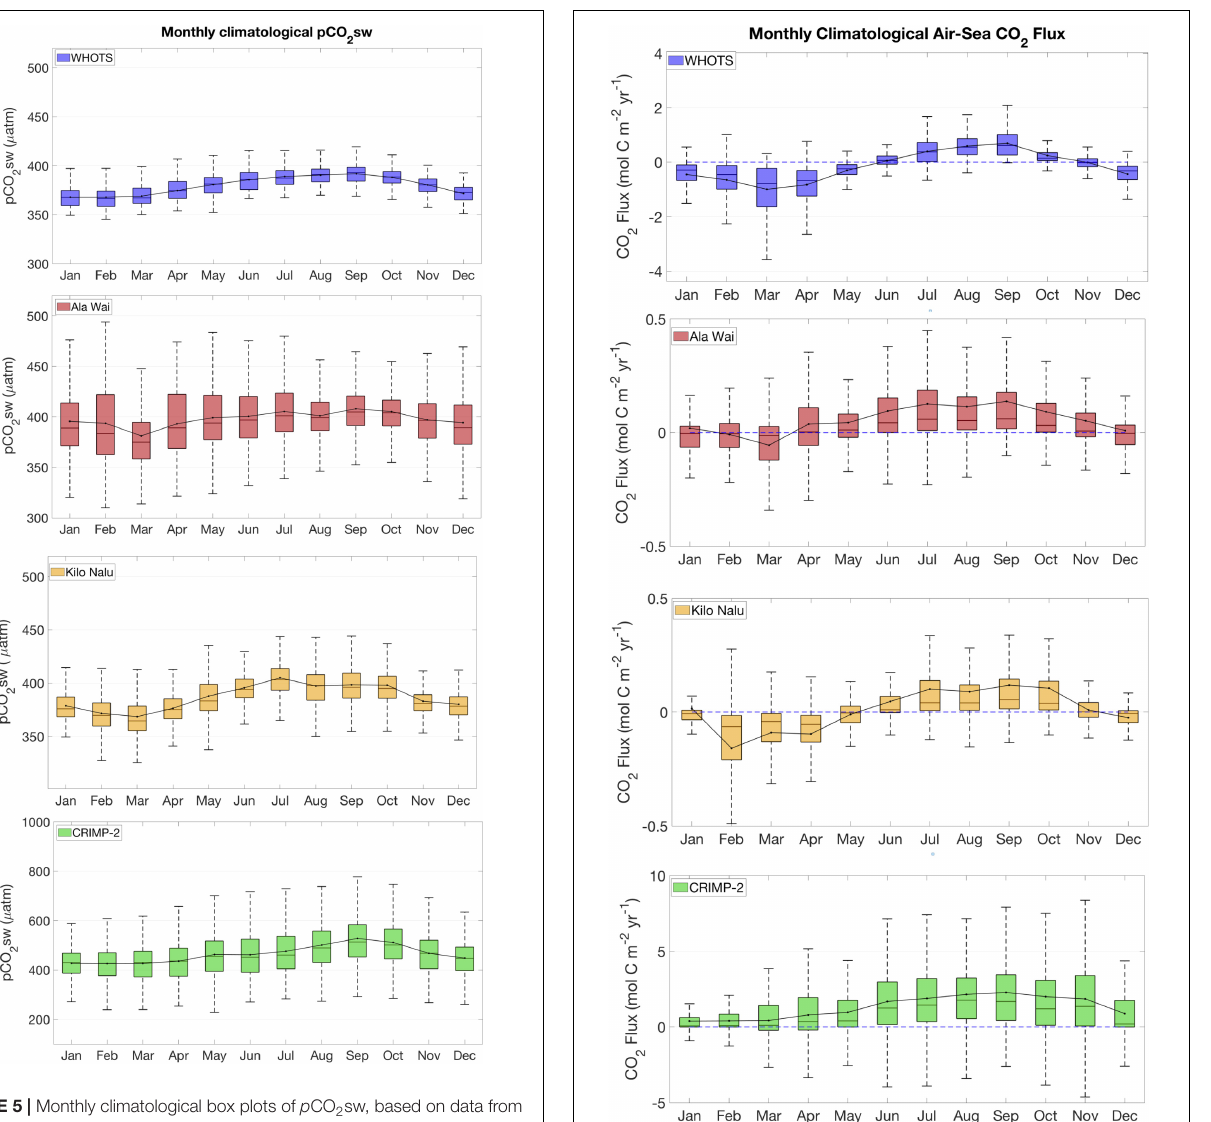
FIGURE 5 | Monthly climatological box plots of p CO 2 sw, based on data from June 2008 through December 2016, at all sites. Box plots show median (line within the box), mean (dot, with a line drawn through the mean of each month), the bottoms and tops of the boxes are the 25th (q 1 ) and 75th (q 3 ) percentiles, respectively. The whiskers extend to 1.5 X interquartile range (q 3 -q 1 ), corresponding to approximately ± 2.7 σ or 99.3% of the data (if normally distributed). Outliers are not included.